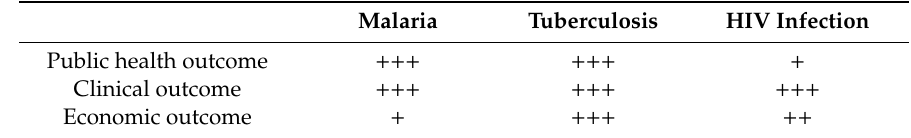
Table 4. Strength of evidence by